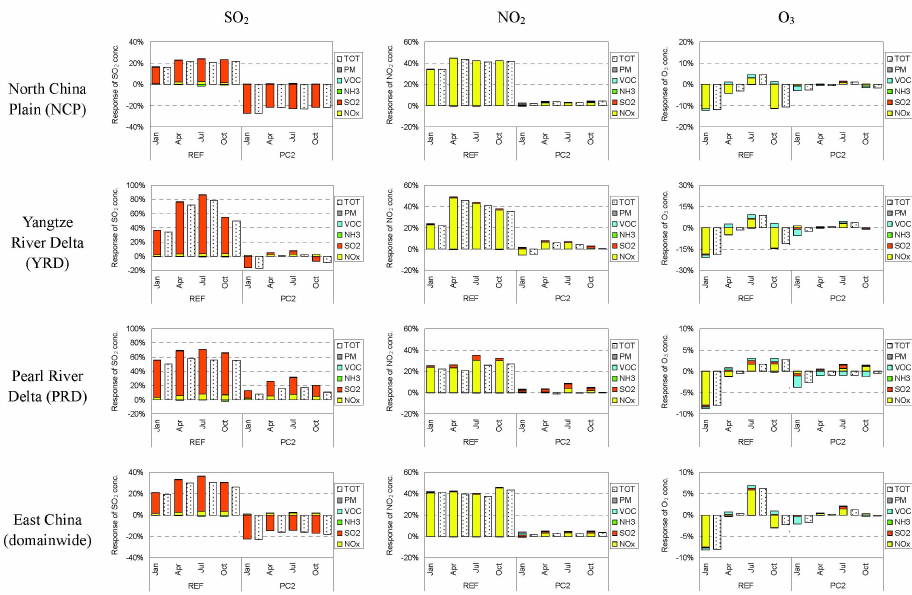
Fig. 7. Percentage changes of surface concentration of gas species relative to the 2005 scenarios in 2020 (monthly average for SO 2 and NO 2 , monthly mean of daily 1-h maxima for O 3 ; TOT represent the differences between two future scenario with 2005 baseline, PM, VOC, NH 3 , SO 2 , NO x represent the individual impacts of their emission changes in